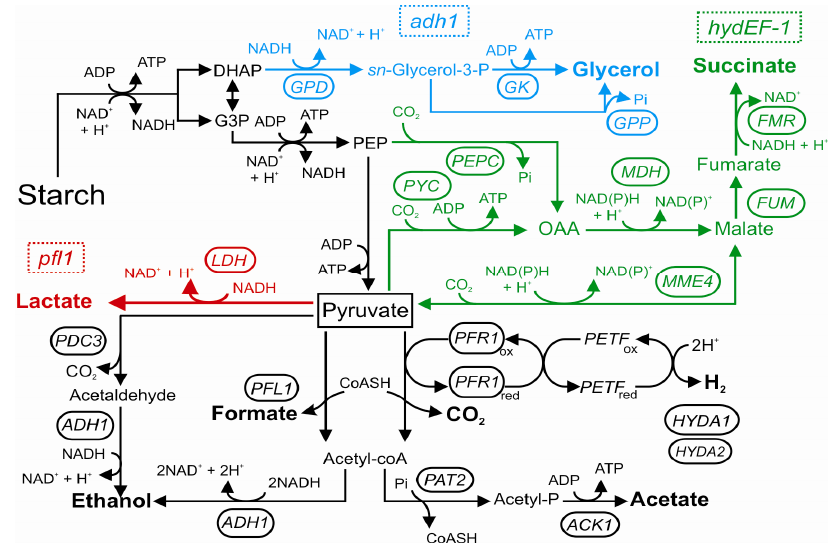
Figure 3. Fermentative pathways of Chlamydomonas reinhardtii . Under dark anoxia starch reserves are metabolized to pyruvate through glycolysis, thus generating ATP and